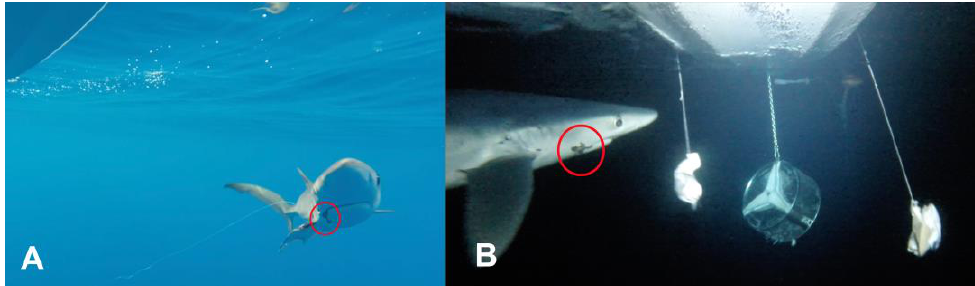
Figure 3. Photographs from video footage of two blue sharks (#S3 and S#2, respectively) that appeared ( A ) during the day and ( B ) at night in “Puerto Soller”. Red circles indicate the presence of embedded hooks in the jaw.